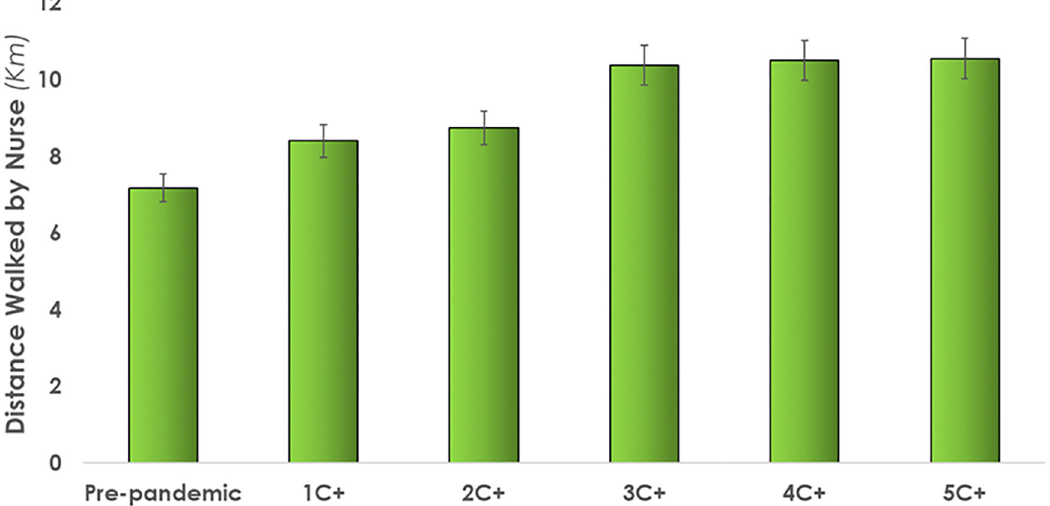
Fig 7. Average distance walked by nurses while attending to different numbers of c+ patients in their patient assignment. Error bars illustrate standard deviations. Table 3 provides a summary of the quantitative results.